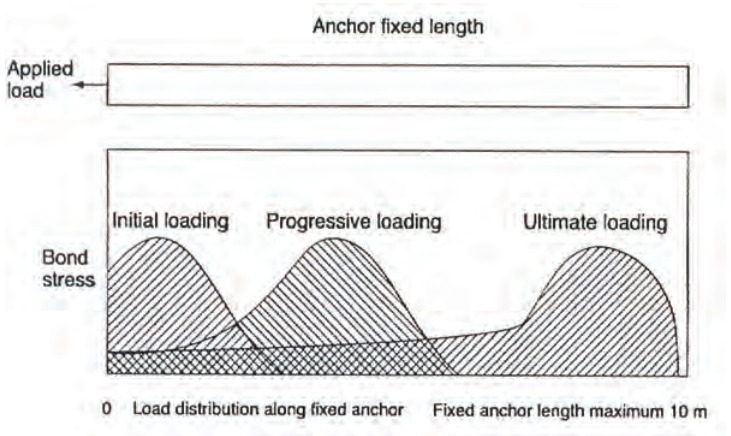
Figure 1. Non-uniform shear stress distribution along the anchor fixed length [6].